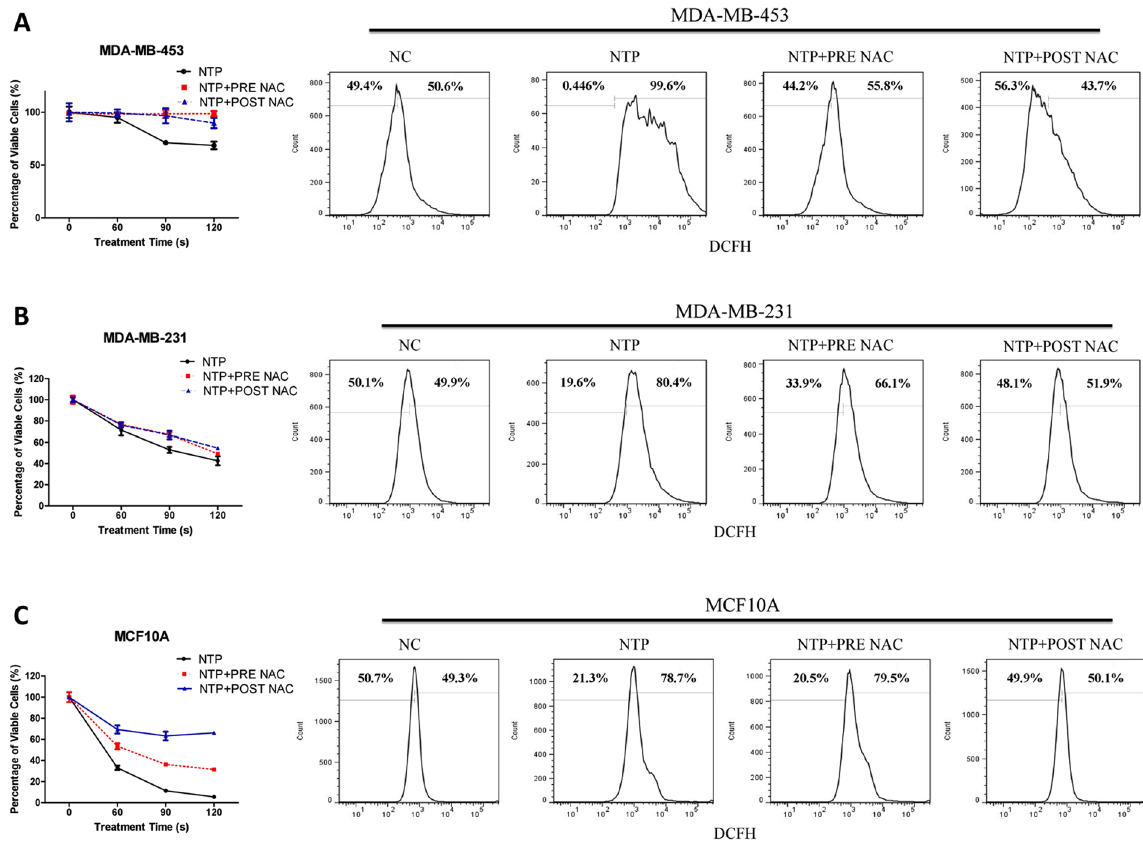
Figure 2. Effects of NTP treatment with or without ROS inhibitor NAC on MDA-MB-453, MDA-MB-231 and MCF10A cells proliferation. Cells were treated with (PRE NAC and POST NAC) or without NAC (NTP) exposed to NTP for 0, 60, 90 or 120 s. Forty-eight hours later, cell numbers of each dish were counted by an automatic analyzer CountStar. ROS fluorescence was analyzed by FACSVerse flow cytometer, 1 h after 120 s NTP treatment. Cells were treated with: Negative Control (NC), 120 s NTP treatment (NTP), pretreat with 5 mM NAC before 120 s NTP treatment (NTP + PRE NAC), post-treat with 5 mM NAC immediately after 120 s NTP treatment (NTP + POST NAC). For improved illustration, a guidance ratio (compared with NC group) has been indicated through histograms. All experiments were replicated a minimum of three